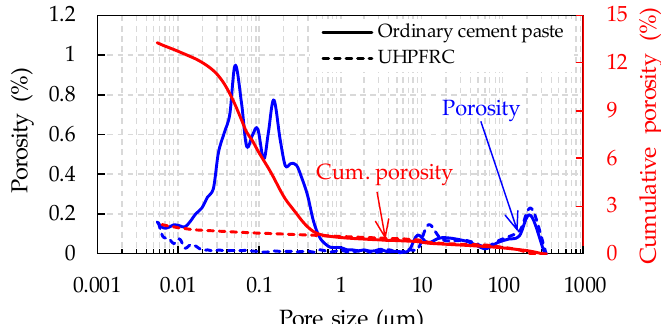
Figure 12. Comparative pore size distribution of ordinary cement paste and UHPFRC.